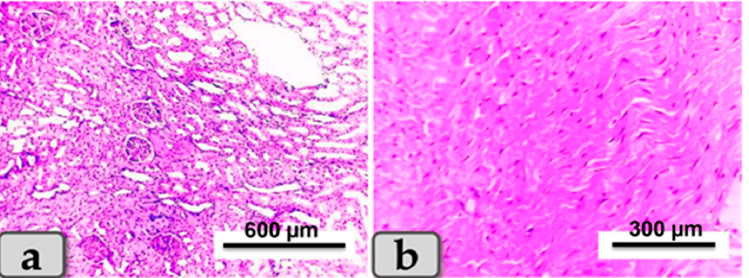
Figure 4. Photomicrograph of a rat’s kidney and heart from the control group (Group 1). ( a ) Showing kidney with normal and intact renal parenchyma, renal cortex and medulla. ( b ) Showing cardiomyocytes with normal, intact cardiac muscle fibers with normal orientations and directions without any pathological lesions. Stain: All H&E.